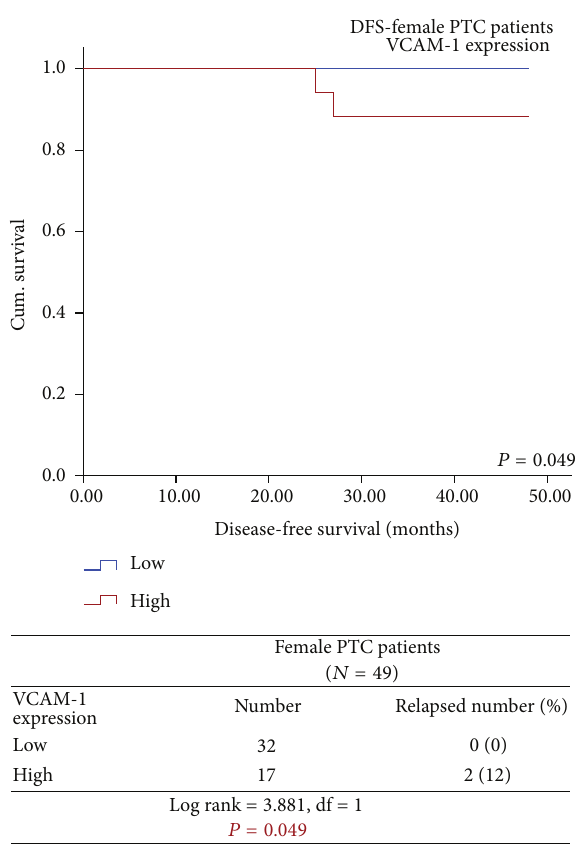
Figure 8: Significantly reduced DFS observed in female PTC patients with high VCAM-1 expression as compared to those with low VCAM-1